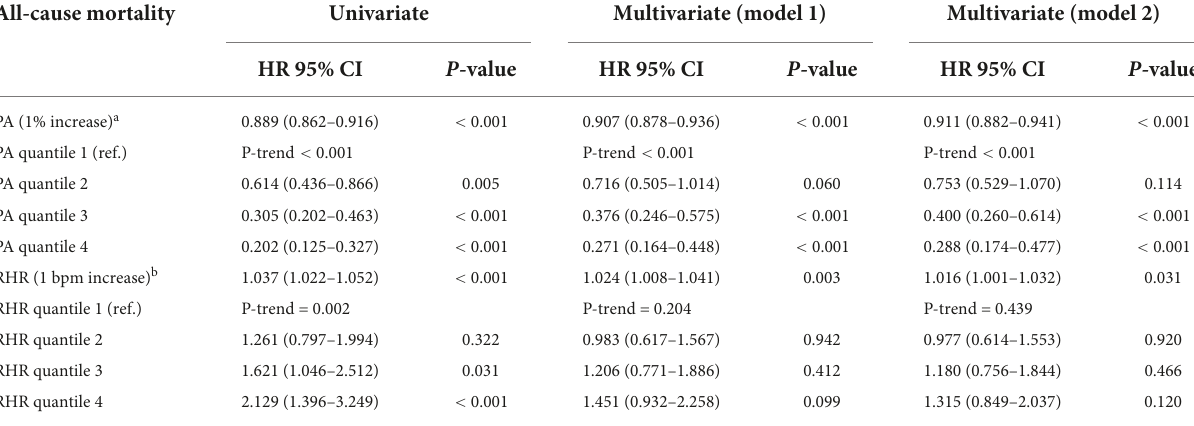
TABLE 2 Predictive values of physical activity (PA) and resting heart rate (RHR) for all-cause mortality outcomes. All-cause mortality Univariate Multivariate (model 1) Multivariate (model 2)